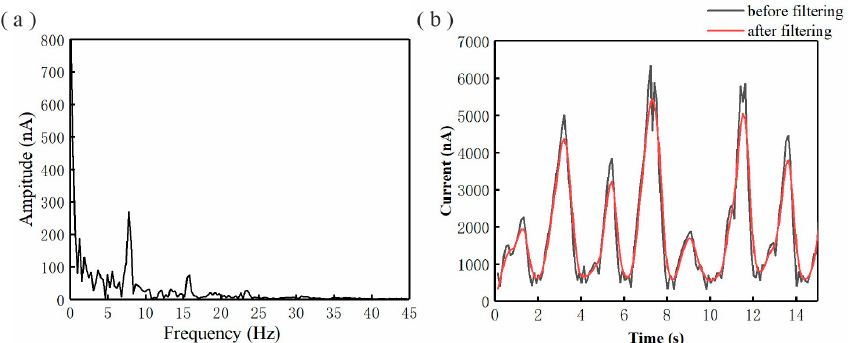
Figure 3. Data processing of micro / nano current: ( a ) amplitude spectrum of EDW current signal; ( b ) EDW current before and after filtering.